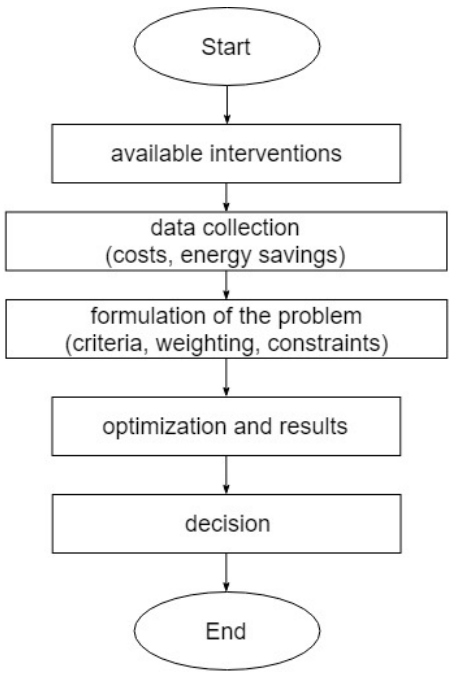
Figure 1. High-level flowchart of the proposed